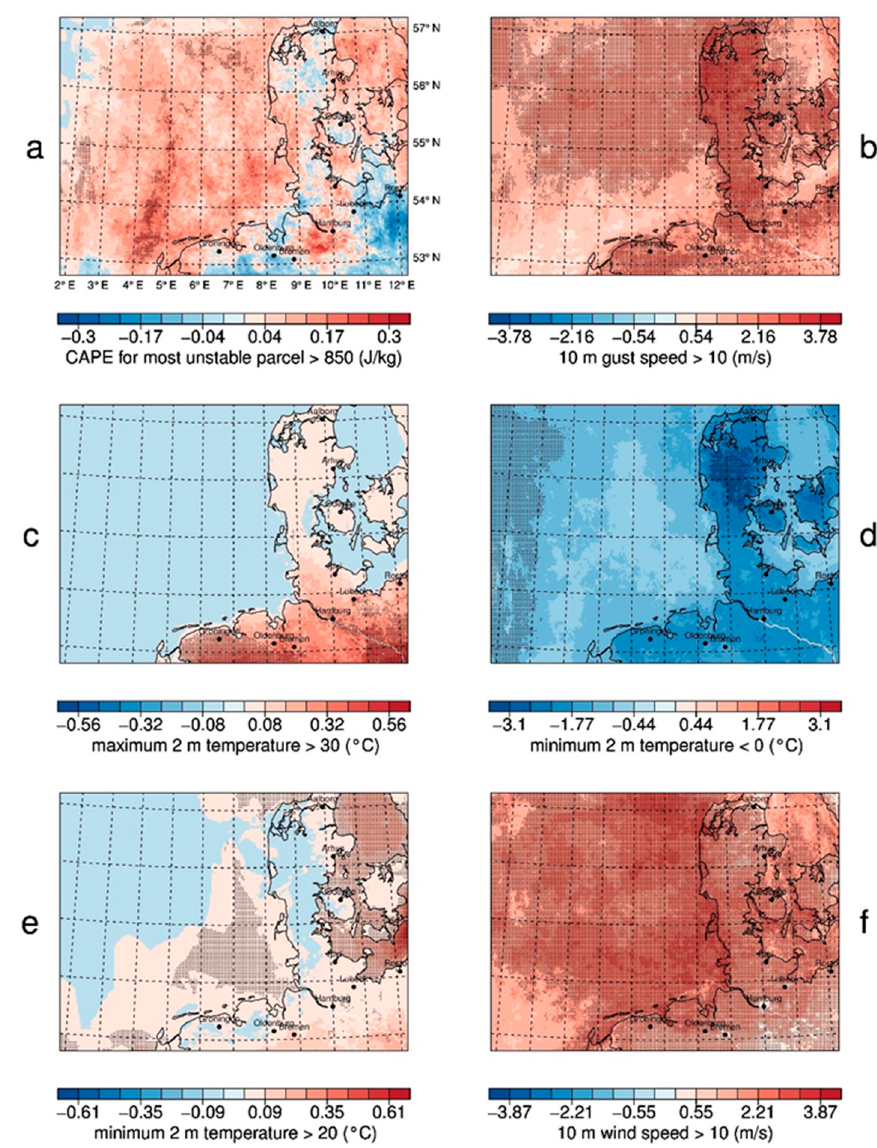
Figure 10. GB0028 decadal trend of annual number of days with ( a ) CAPE higher 850 J/kg, ( b ) 10 m gust speed higher than 10 m/s, ( c ) maximum 2 m temperature higher than 30 °C (hot days), ( d ) minimum 2 m temperature lower than 0 °C (frost days), ( e ) minimum 2 m temperature higher than 20 °C (tropical nights), ( f ) 10 m wind speed higher than 10 m/s. Shaded areas indicate a statistical significance at the nominal 5% level.